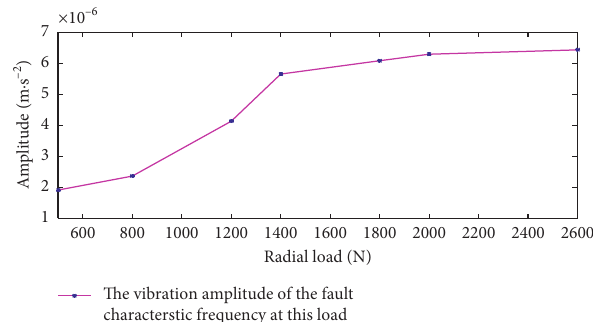
Figure 23: The trend of different loads at the 1772rpm and the defect size is 0.014